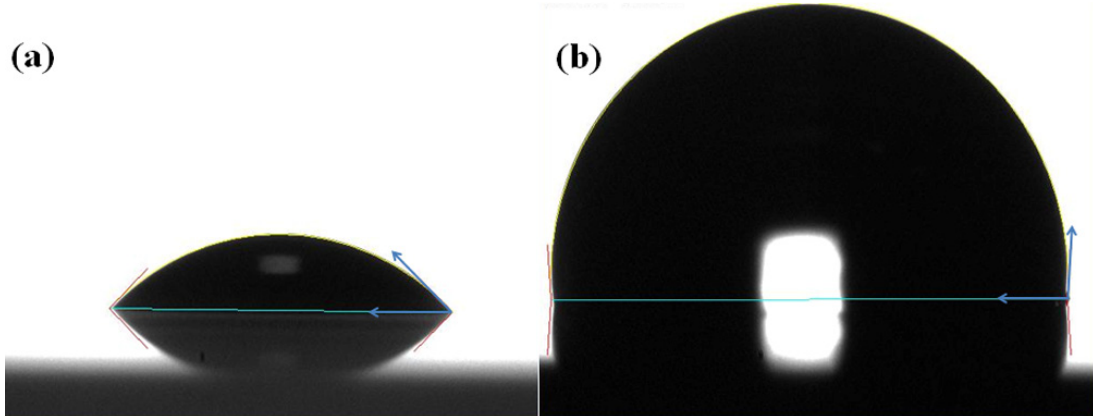
Figure 2. The contact angle image of ( a ) glass substrates and ( b ) mild steel